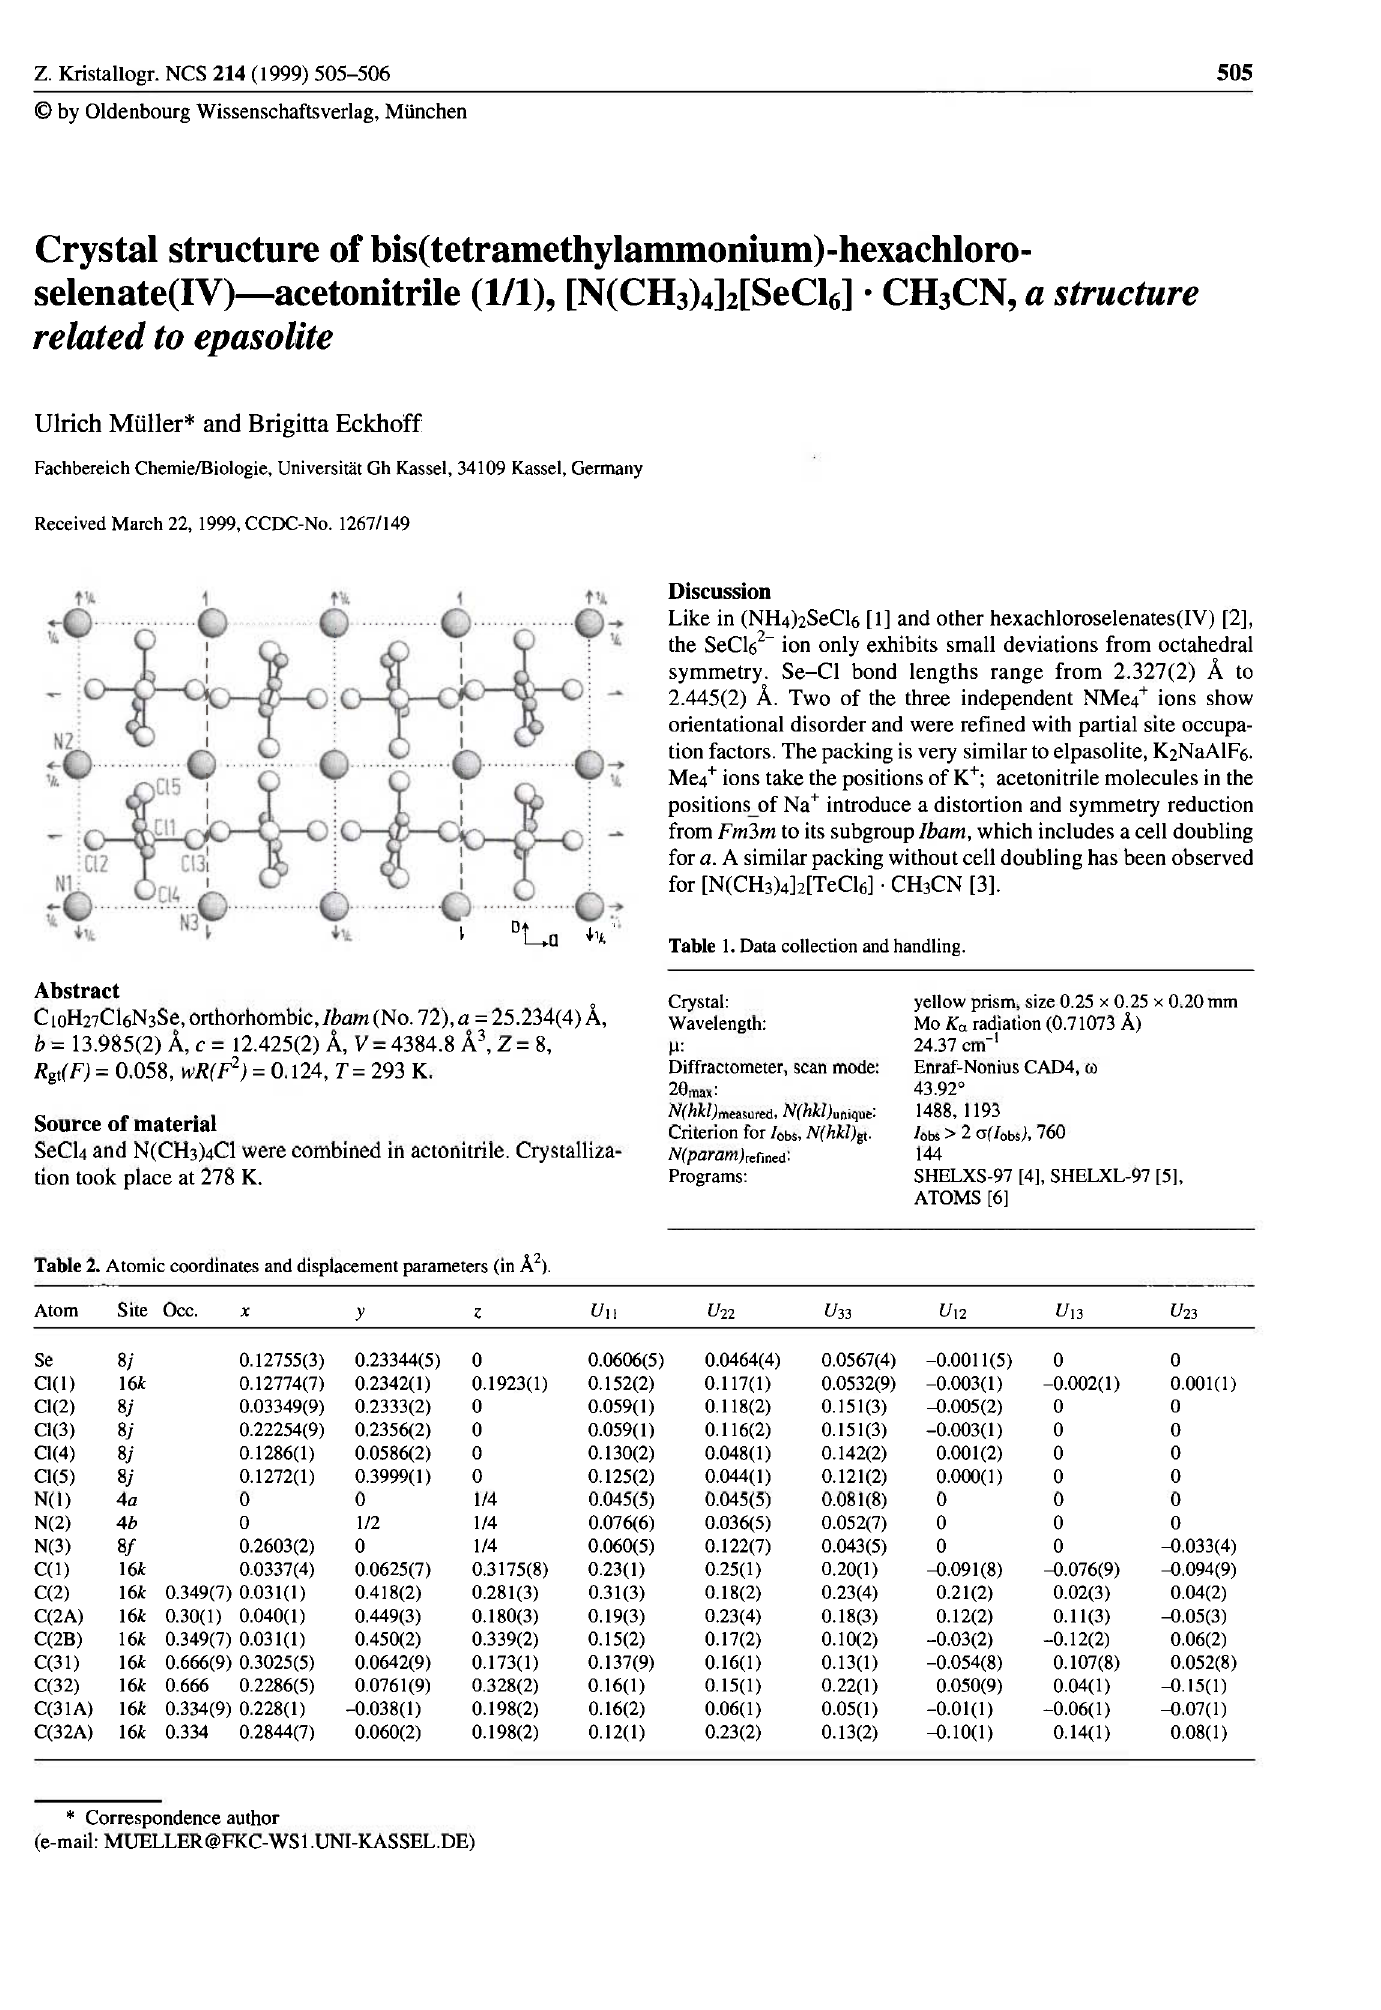
Table 2. Atomic coordinates and displacement parameters (in Ä 2 ).